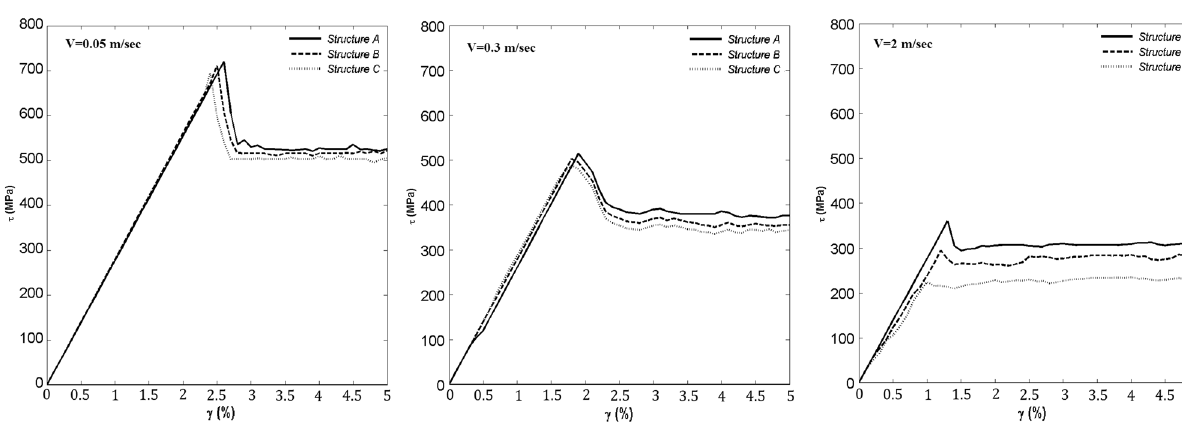
Figure 5. Shear stress–shear strain diagrams for the three structures for several